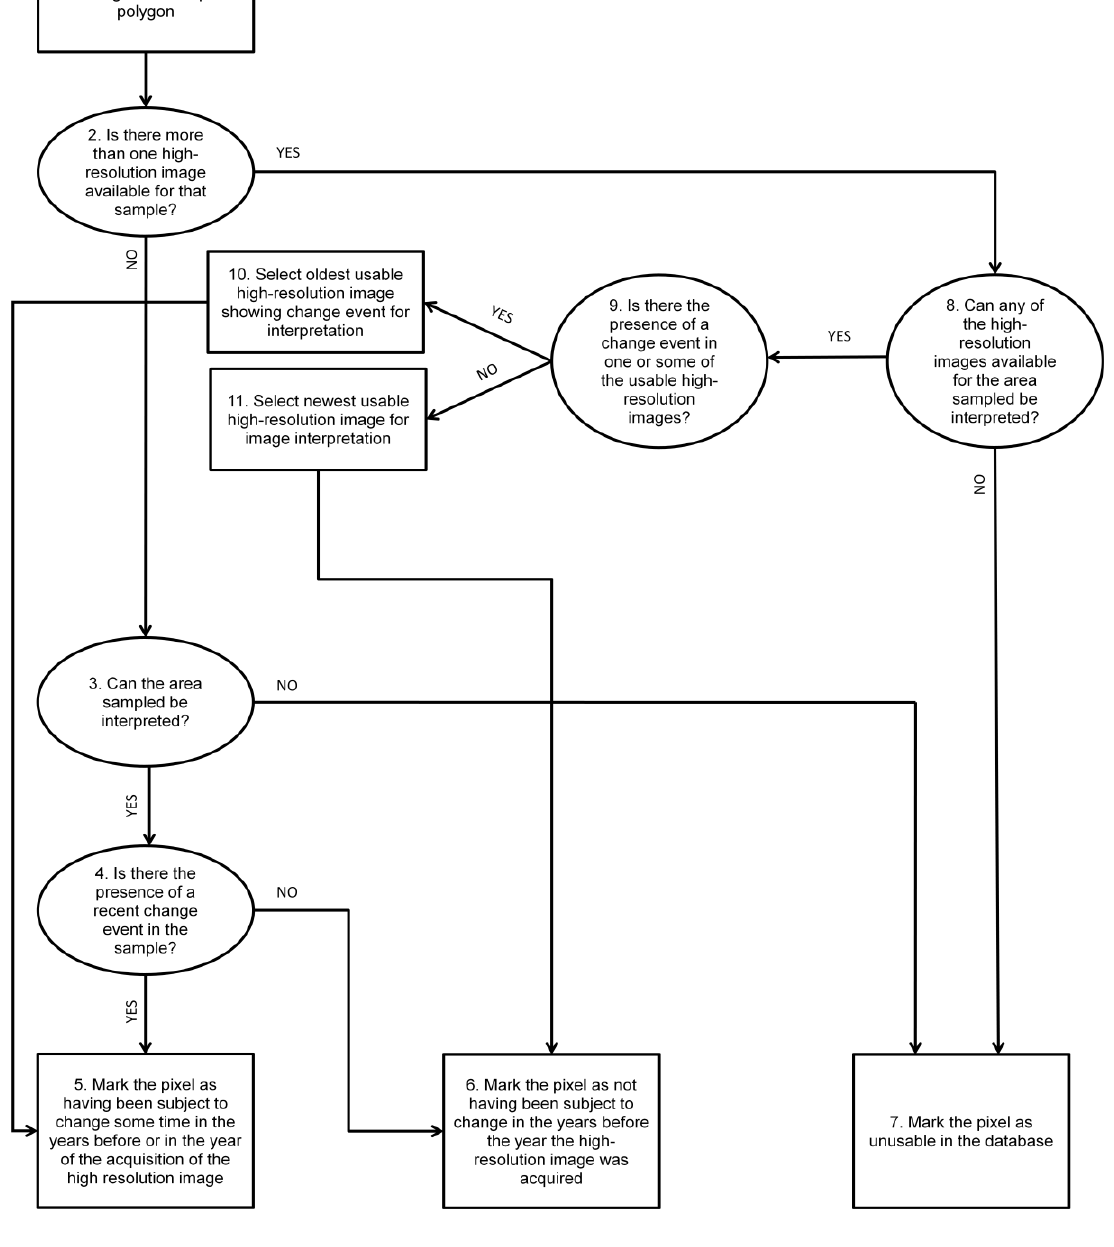
Figure 2. Validation sample interpretation and validation database building